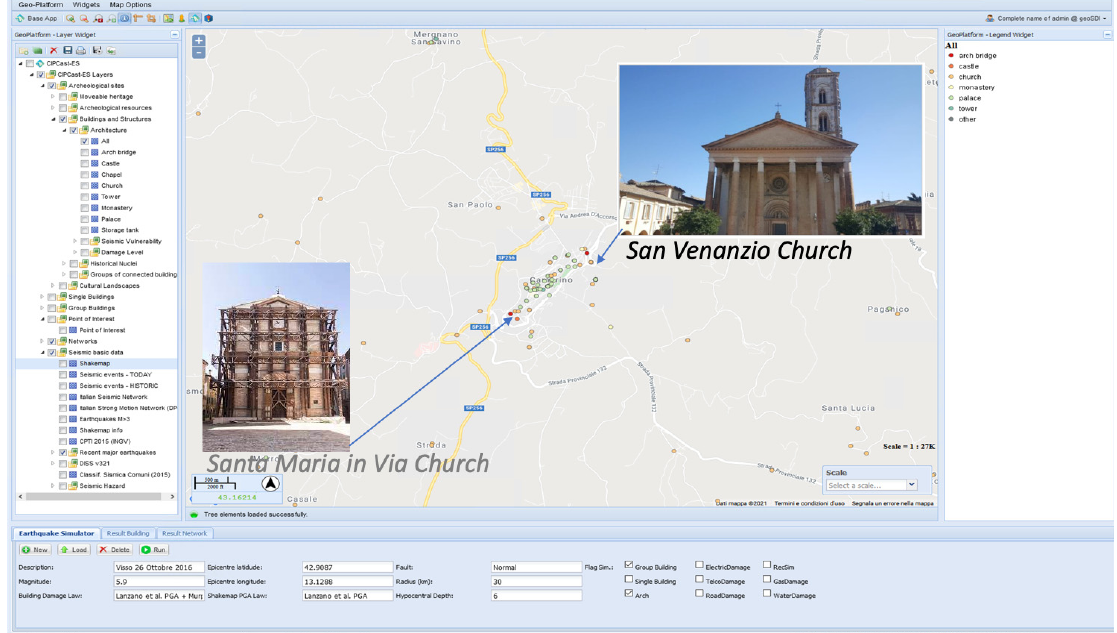
Figure 10. ARCH DSS exposure GUI showcasing the different types of CH in Camerino HA and pictures of the two iconic churches, i.e., San Venanzio and Santa Maria in Via.